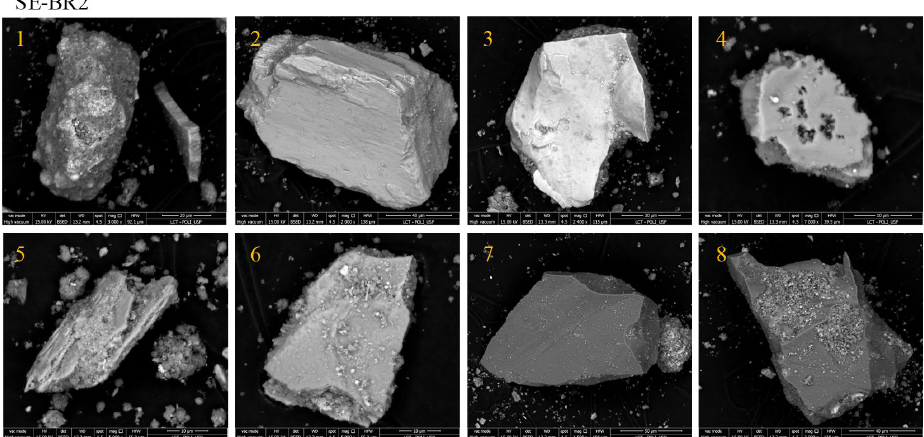
Figure 6. SEM images of SE-BR2. EDS illustrates the presence of: 1 – Al; Fe; Si, Na, Ti; 2 – Al; Fe; 3. Ti, Fe, Mn; 4 – Al, Fe; 5 – Al, Fe, Si, Na; 6 – Al, Fe; 7 and 8 –